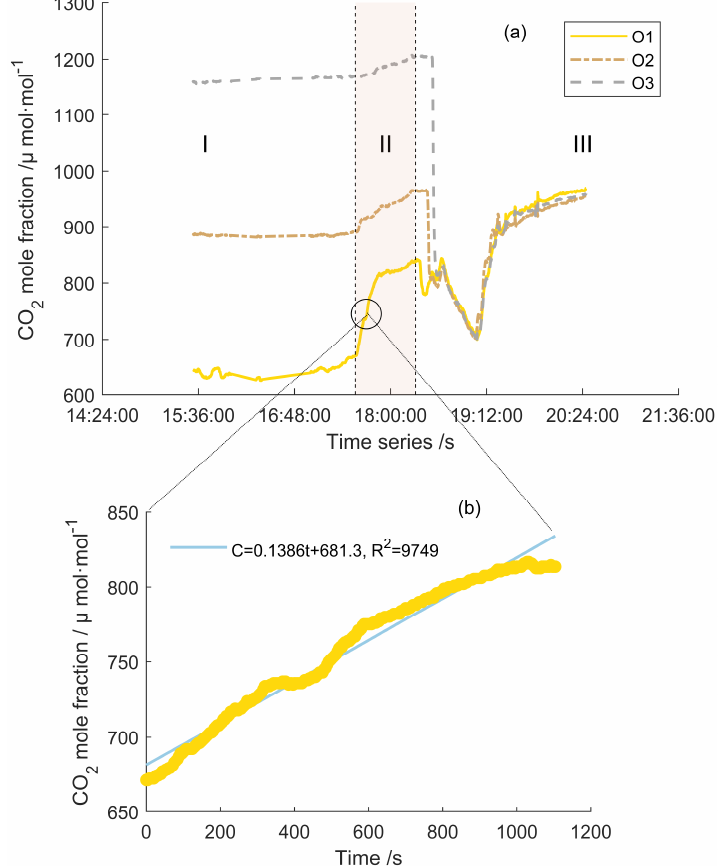
Figure 8. ( a ) Variation of CO 2 concentration values in O1–O3 layers of sandy loam, under stable conditions after aeration; ( b ) Stage II, sandy loam O1 layer, concentration variation condition and fitted curve after continuous pumping of 100 mL.